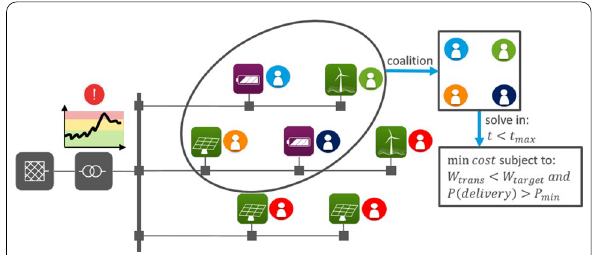
Fig. 2 An example decentralized congestion management system. When a congestion is detected, agents autonomously form